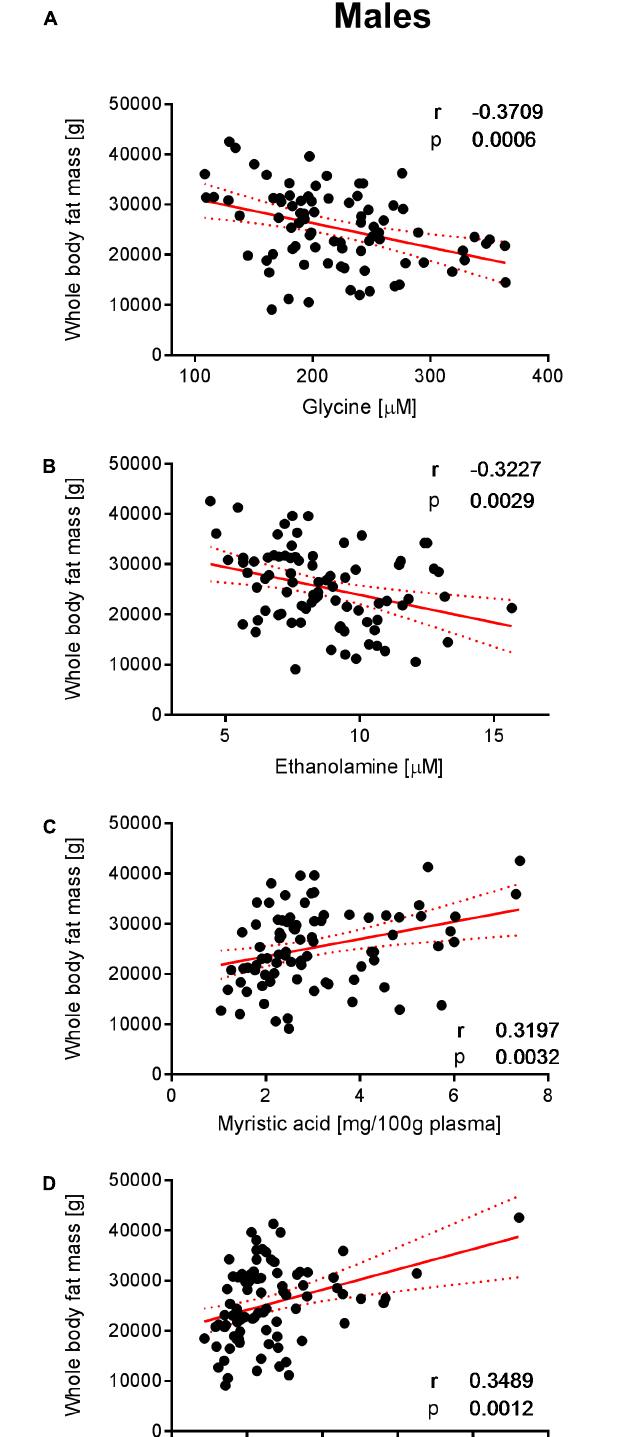
Frontiers in Physiology |